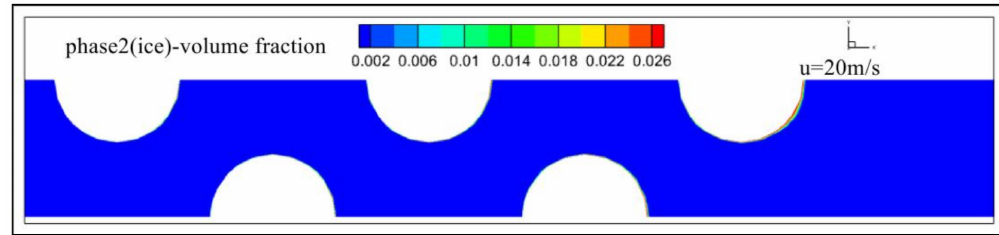
Figure 18. Frost morphology at flow velocity 20 m/s (5th